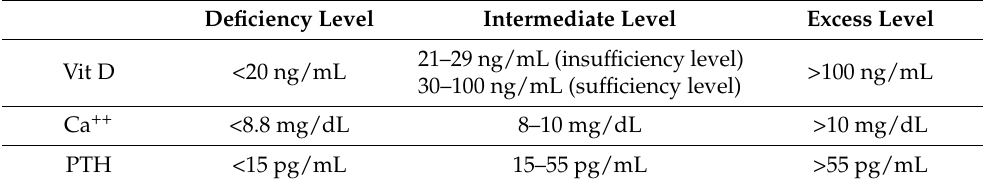
Table 1. Serum levels cut-off for biological variables. Deficiency